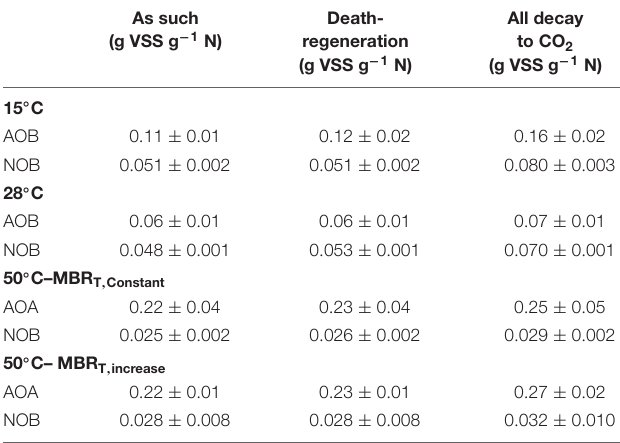
TABLE 5 | AOB/AOA and NOB yield of a mesophilic nitrifying inoculum at 15 and 28 ◦ C and of two thermophilic nitrifying communities at 50 ◦ C, determined as such, corrected for the dilution of 13C medium by biomass decay according to the death-regeneration concept and the worst-case scenario where all dead biomass was converted to CO 2 .